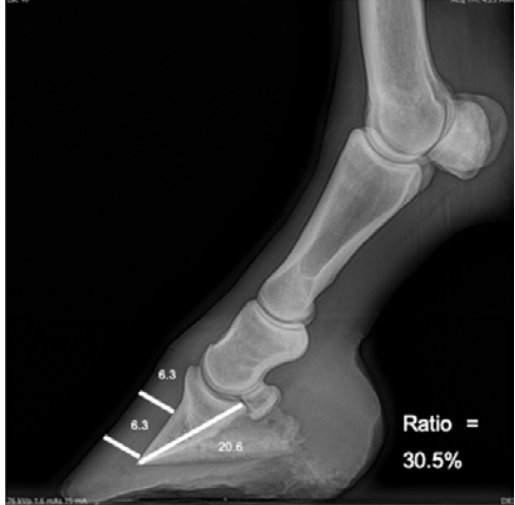
Figure 3: Lateromedial projection of the foot of a sound 8-year-old Arab mare revealing an increased dorsal hoof wall to palmar P3 length ratio.